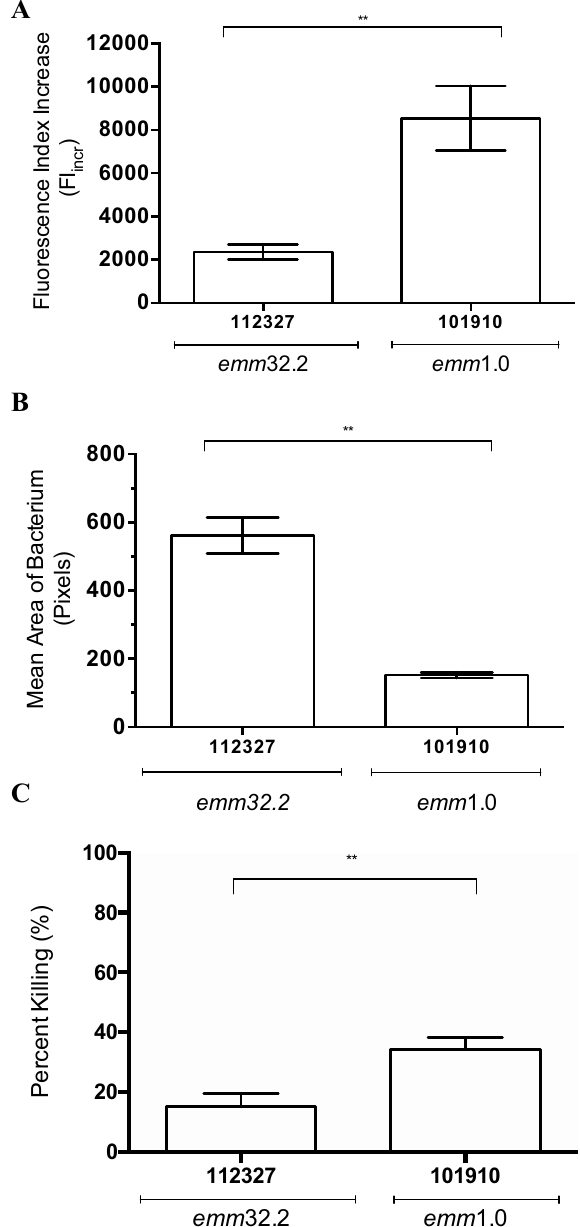
Figure 1. Comparison of capsule thickness, complement deposition, and OPK survival between emm type 32.2 (isolate 112,327) and emm type 1.0 (isolate 101,910). ( A ) Complement deposition (Fi). ( B ) Capsule thickness (mean-pixels) and ( C ) percent killing by macrophages. Analysed using a two-tailed Mann Whitney U-test, **p < 0.01, ***p <